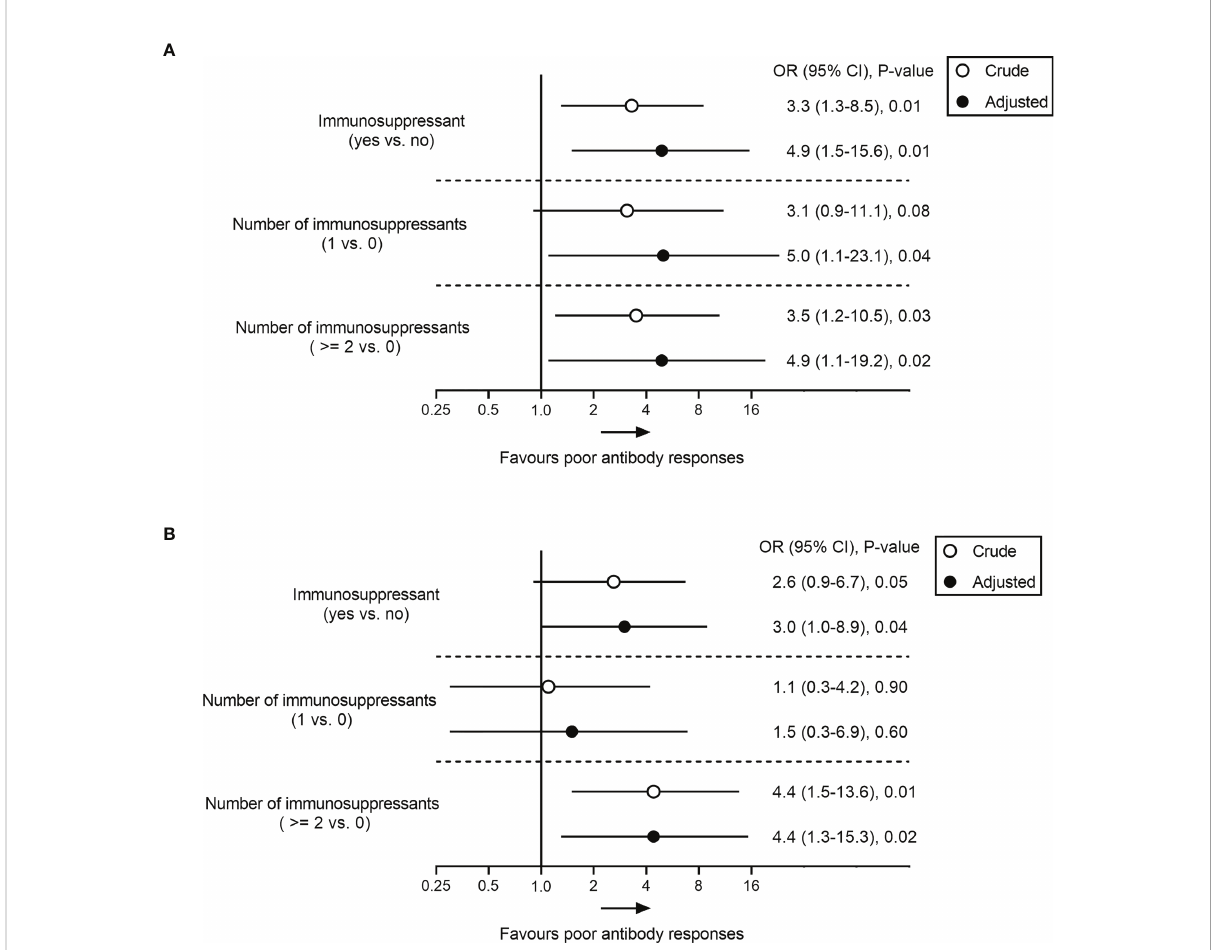
FIGURE 2 Association analysis between immunosuppressant and poor antibody responses to SARS-CoV-2 vaccine in patients with AILD. Odds ratio (95% CI) of poor response to RBD-IgG (A) and NAbs (B) in immunosuppressant-treated AILD patients in crude (unadjusted) and adjusted models compared with healthy controls. The adjusted model was adjusted age, BMI, sex, cirrhosis, comorbidities, types of vaccine, and days between fi nal dose and antibody test. AILD, autoimmune liver diseases; BMI, body mass index; CI, con fi dence interval; OR, odds ratio; SARS-CoV-2, severe acute respiratory syndrome coronavirus